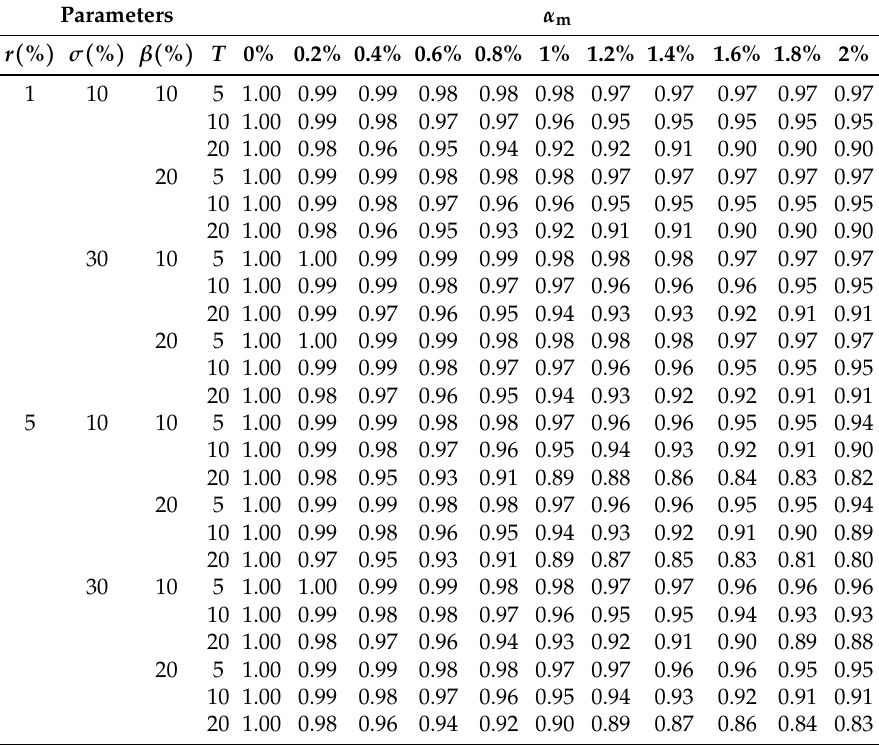
Table 3. Total value V ( 0, X ( 0 ) ; Γ G ) based on the guarantee value maximization strategy Γ G . Parameters α